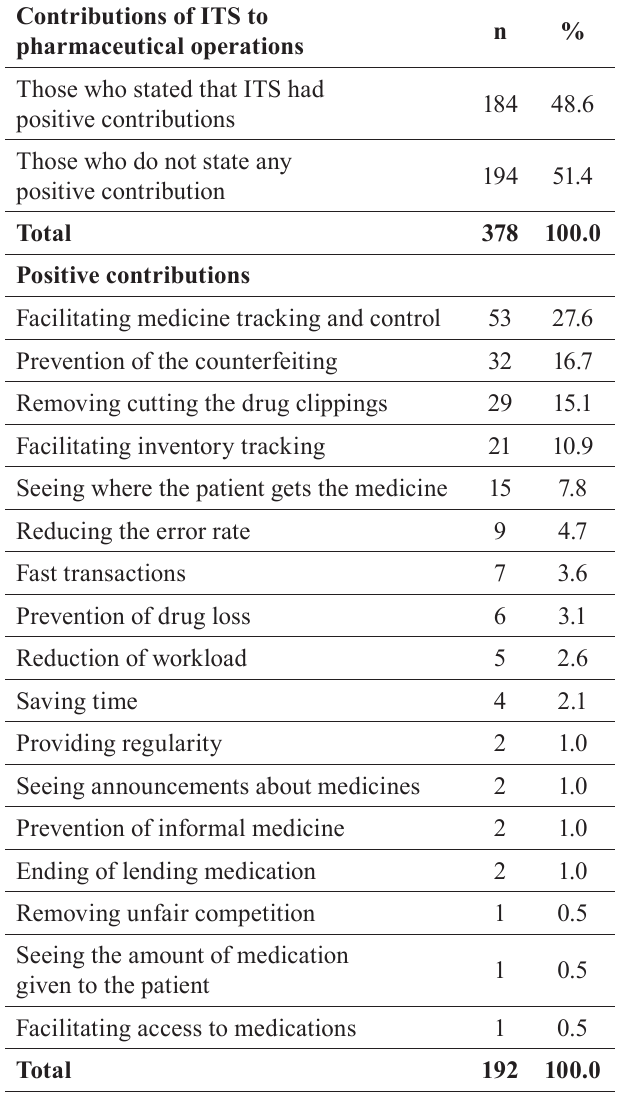
TABLE III - Positive contributions of ITS to the pharmacists’